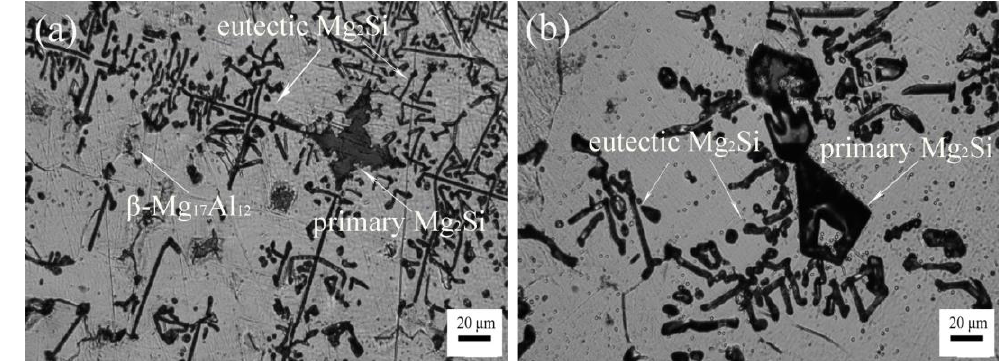
Figure 12. Optical micrographs of the as-cast alloys ( a ), and the solution-treated alloys ( b ).